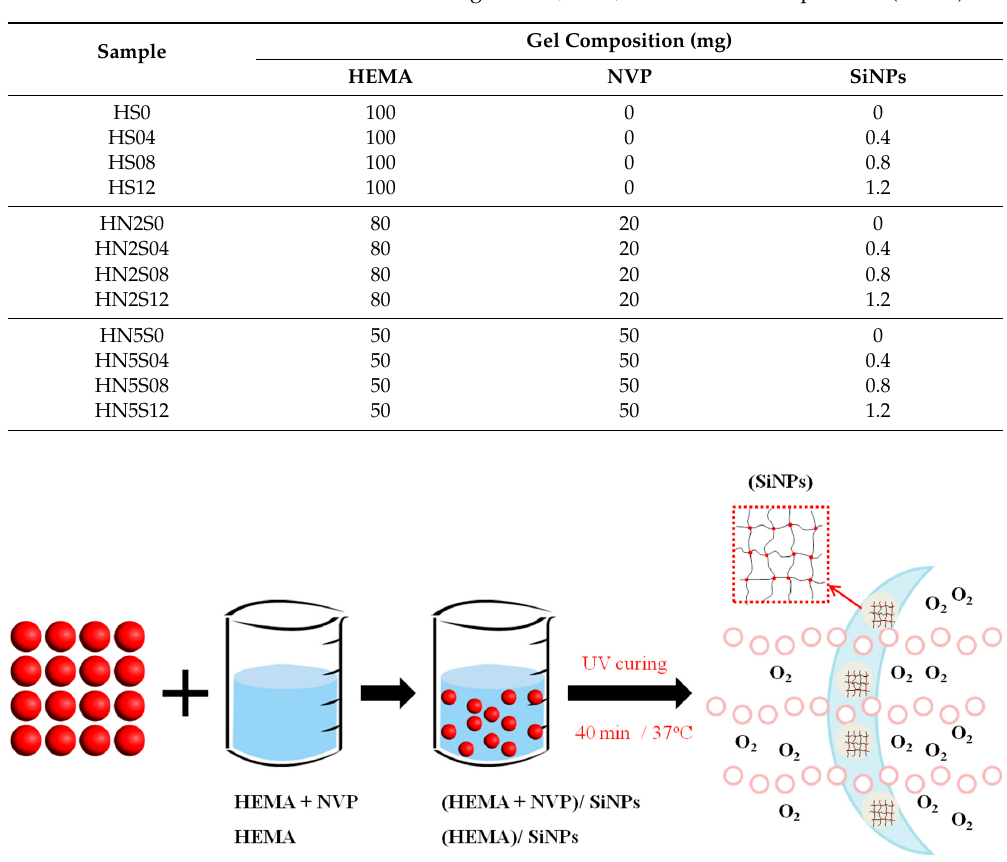
Table 1. Formulation of soft lenses including HEMA, NVP, and silicone nanoparticles (SiNPs).